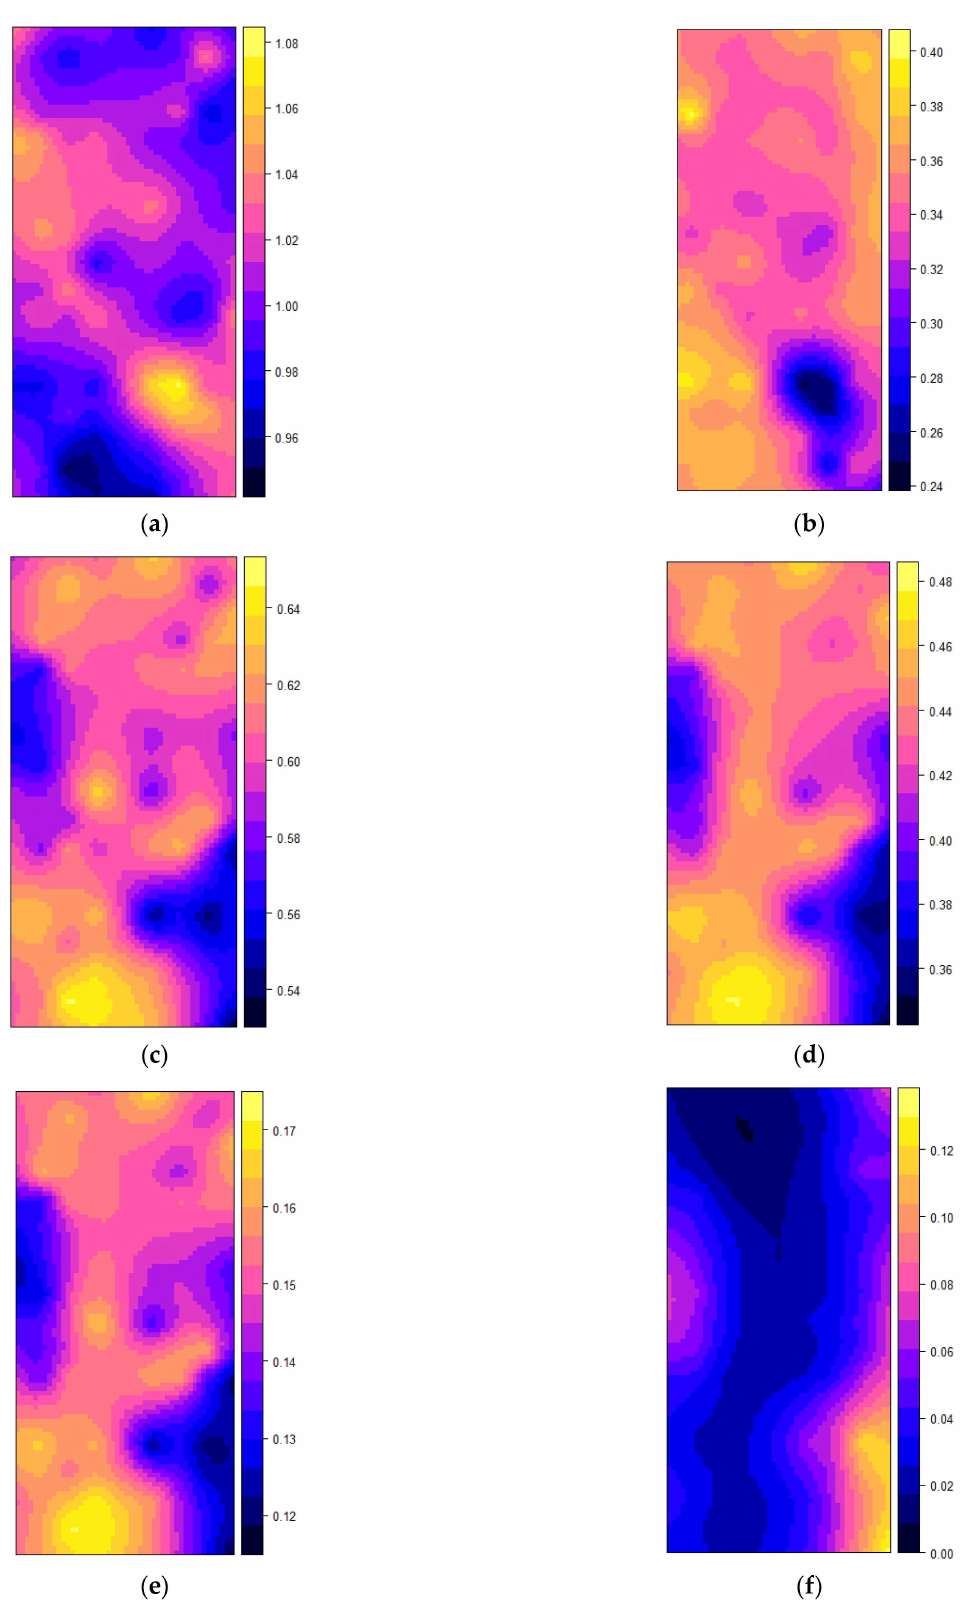
Figure 2. Maps of the interpolated values of BD ( a ), θ i ( b ), θ 10 ( c ), θ 100 ( d ), θ 15,300 ( e ), Ks ( f